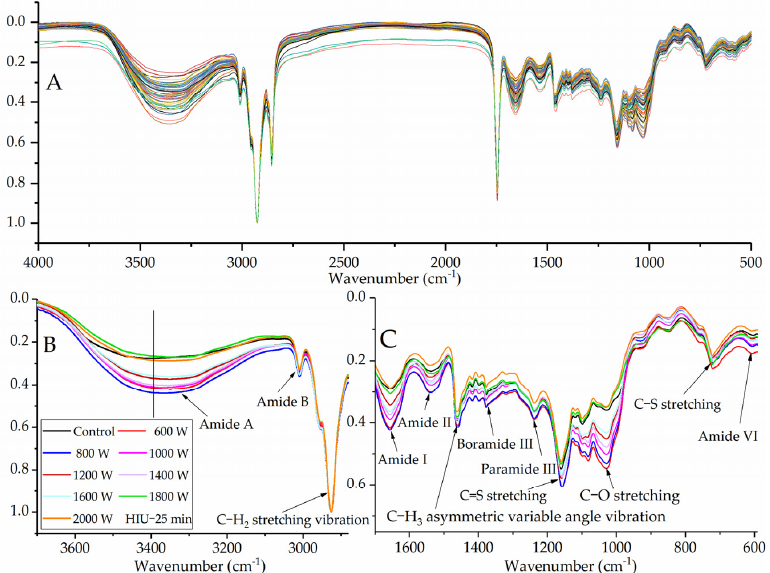
Figure 2. FTIR spectra of WPI after HIU treatment (( A ): 4000–500 cm − 1 ) and HIU treatment for 25 min (( B ): 3400–2800 cm − 1 , ( C ): 1800–600 cm − 1 ).